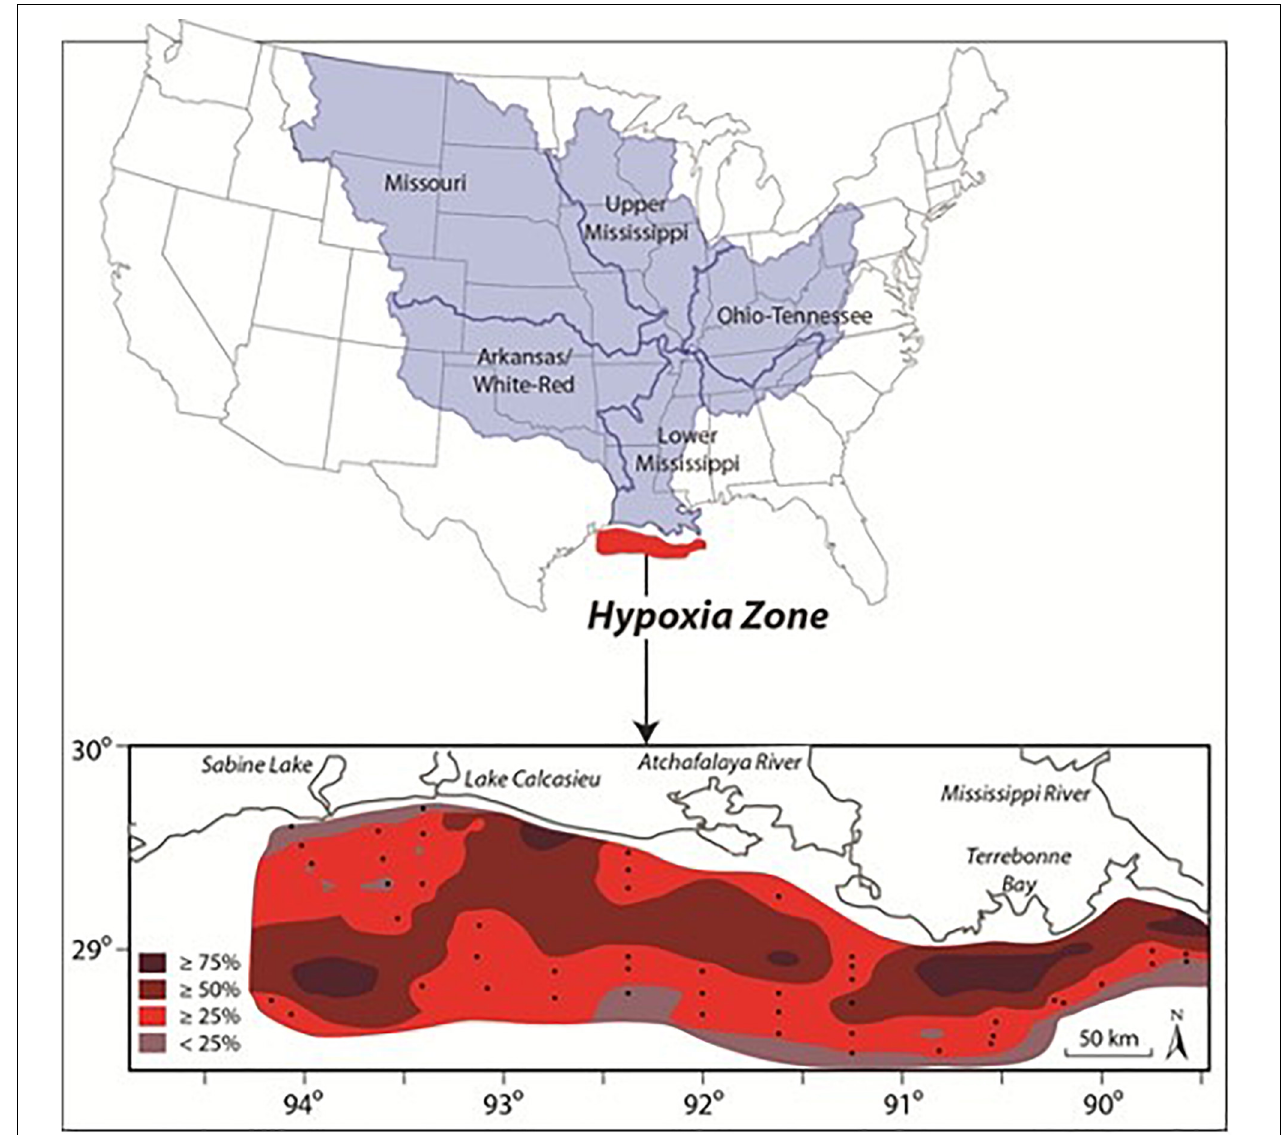
FIGURE 4 | Mississippi-Atchafalaya River Basin and the frequency (percent occurrence) of mid-summer bottom-water hypoxia off the coast of Louisiana and Texas during 1985–2008 (inset) (Source: Center for Agricultural and Rural Development, Iowa State